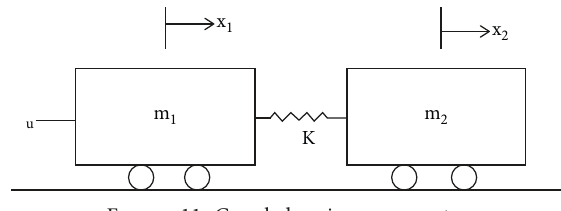
Figure 11: Coupled spring-mass system.